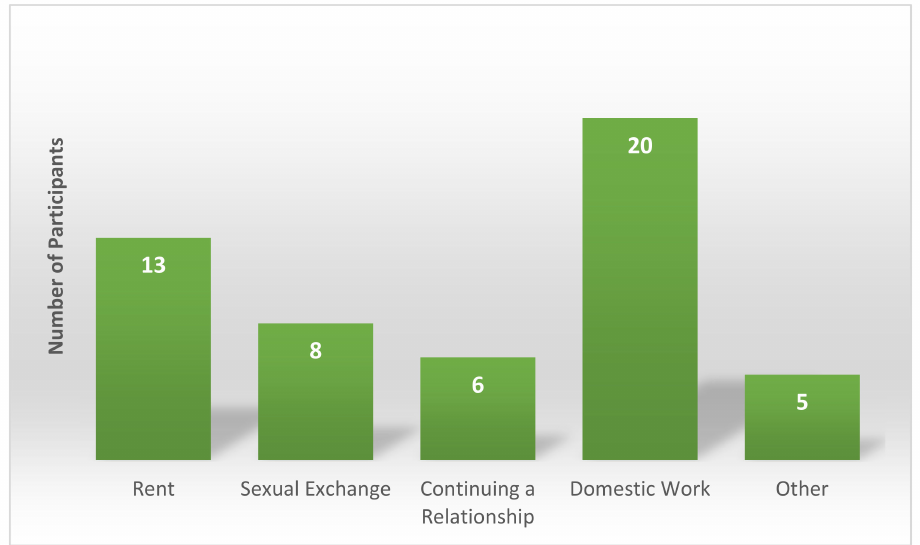
Figure 2. What was exchanged for couchsurfing. The totals here do not equal the sample size as many young people exchanged multiple items or services to secure housing over the course of their couchsurfing. “Other” included providing transportation, exchanging drugs, or doing grocery